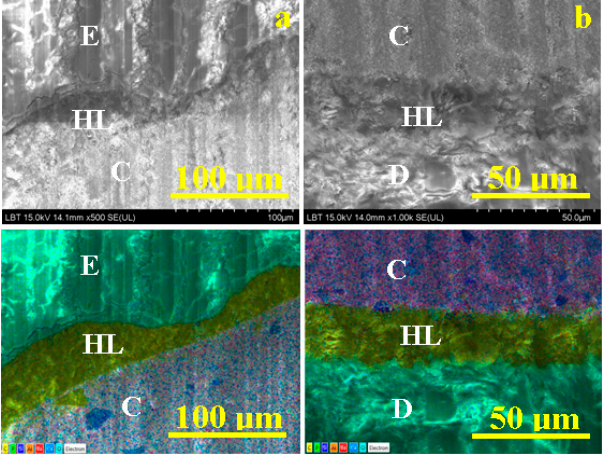
Figure 6. SEM images for Score 0 in Group B: ( a ) Composite (C) — enamel interface (E); ( b ) Composite (C) — dentin (D) interface; HL — hybrid layer. EDX mappings are given below for each SEM electron image.